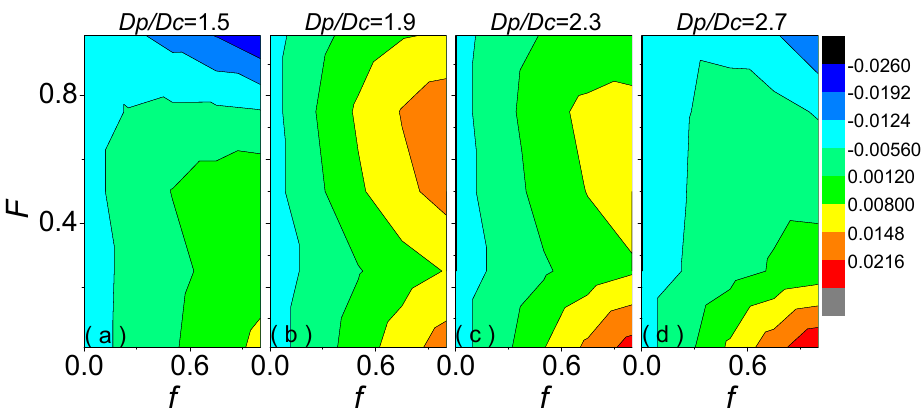
Figure 7. Absolute differences between the absorption enhancement of BC reduced by the blocking effect of an absorbing coating approximated with Equation (9) and those produced by exact numerical simulations. Four shell/core ratios of 1.5, 1.9, 2.3, and 2.7 are shown from left to right. A BC fractal dimension of 2.8 and log-normal size distribution with r g of 0.075 µ m and σ g of 1.59 are con- sidered.